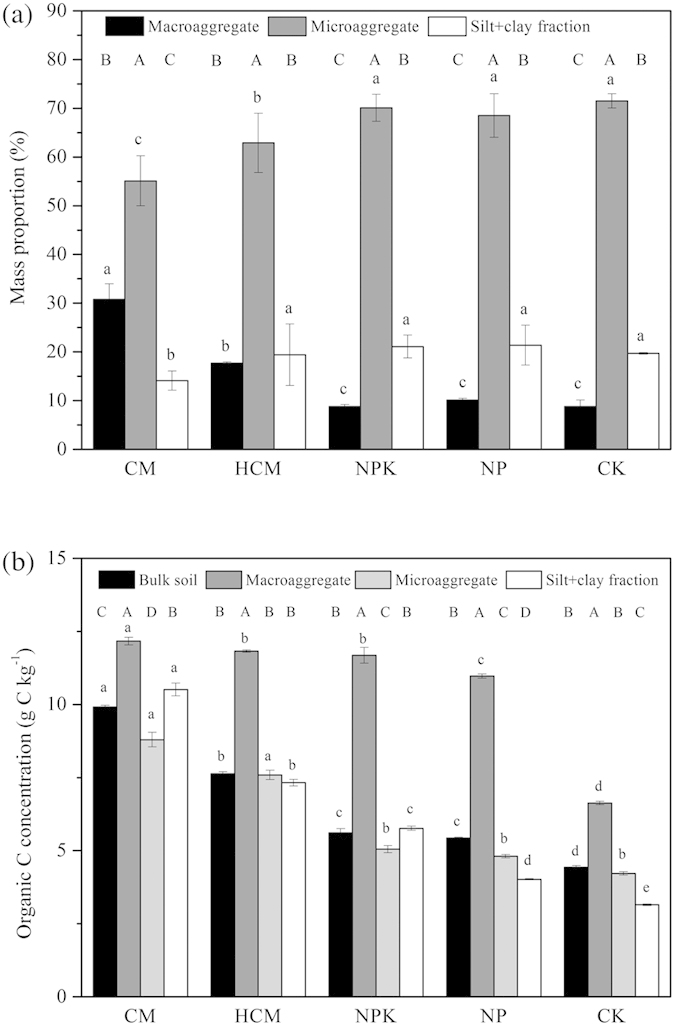
Mass proportion of aggregates (a) and organic C content (b) in bulk soils and aggregates, as affected by long-term application of compost and mineral fertilizers.Different lowercase letters indicate significant differences between treatments for the same aggregate, and different capital letters indicate significant differences between aggregates for the same treatment (Tukey’s test, P < 0.05, n = 4).